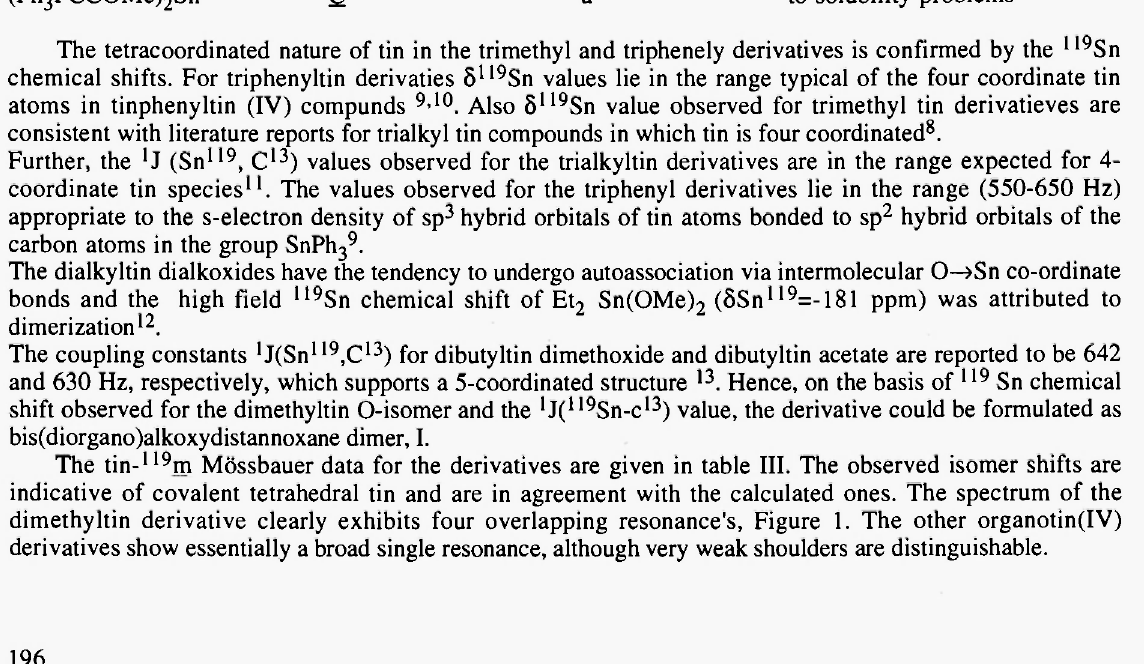
Table II: n 9 Sn NMR Data for Tin-substituted